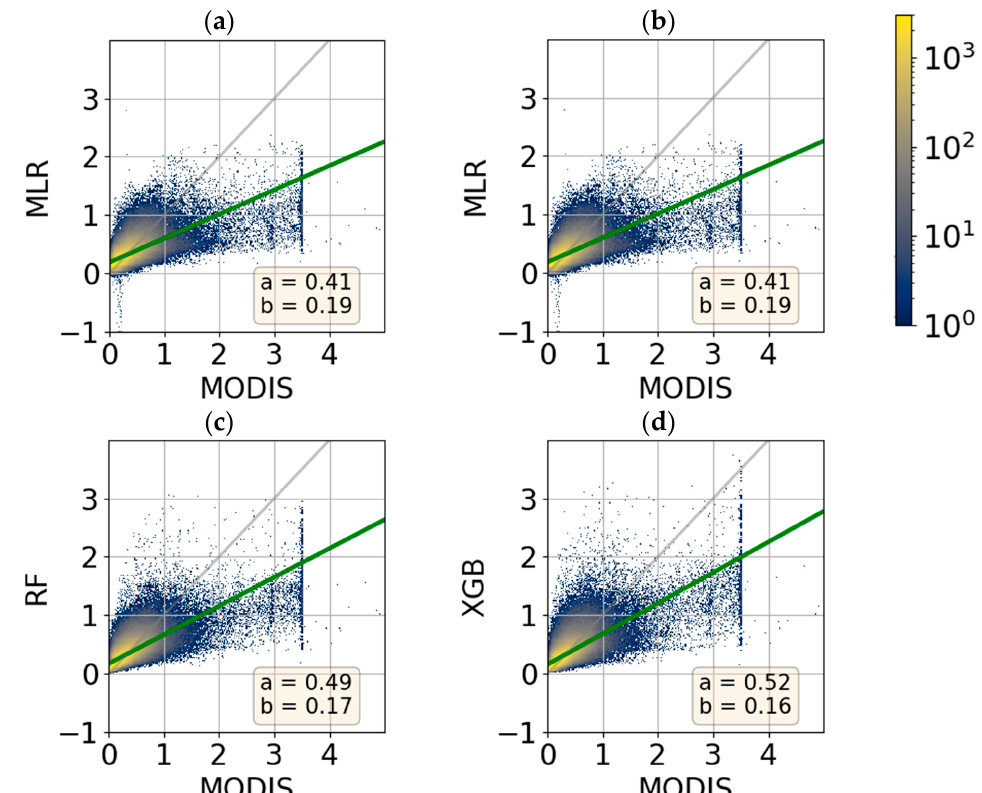
Figure 10. Scatterplots of corrected AOD 550 inferred by the ( a ) MLR, ( b ) NN, ( c ) RF, and ( d ) MLR models, with respect to AOD measurements from MODIS for D Test . The green line represents the linear fit with a slope a and the intercept b. The gray lines represent the lines y = x . Colormap represents the occurrence. The apparent limit of the MODIS AOD at the value 3.5 is an arbitrary upper limit fixed by the original Deep Blue retrieval algorithm.